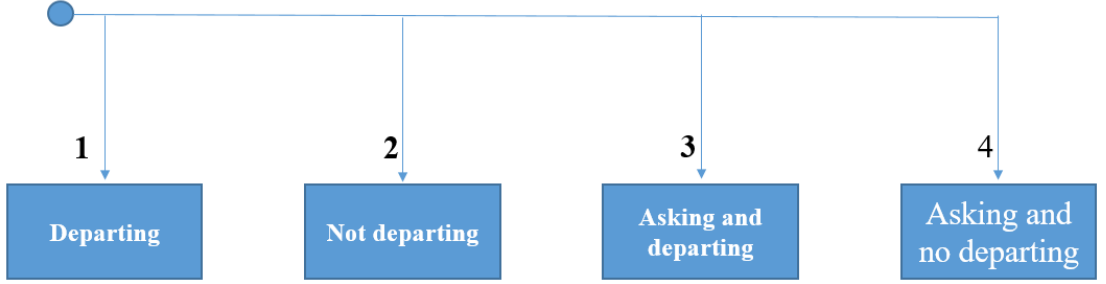
Figure A6. Situation 6—Total calm. Note. 1 = execution; 2 = doing nothing; 3 = communication and giving orders; 4 = communication and